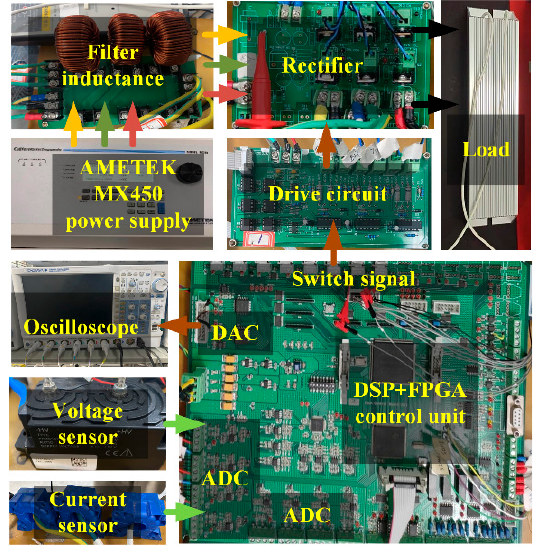
Figure 9. Experimental platform.